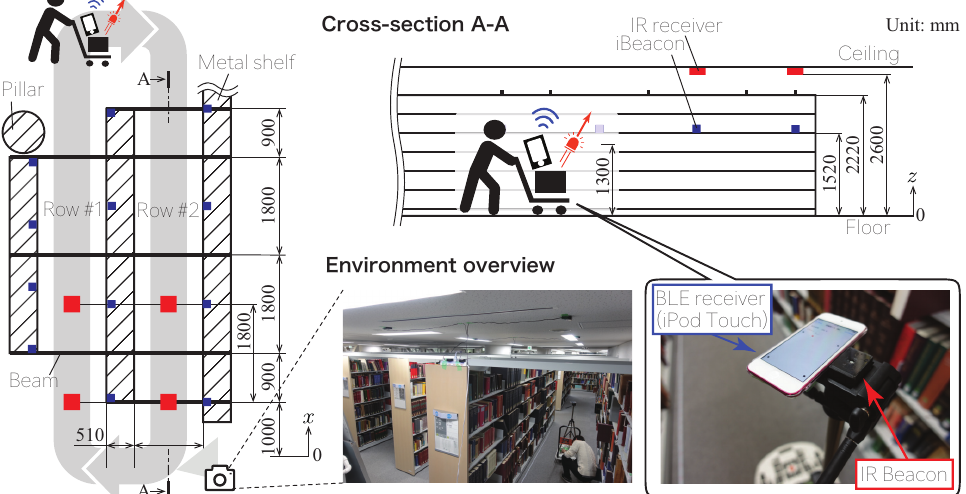
Figure 4. Passage environment surrounded by metal shelves. An IR beacon and Bluetooth Low- Energy (BLE) receiver (iPhone operating system based device) were placed on the cart, as a mobile object, to perform positioning